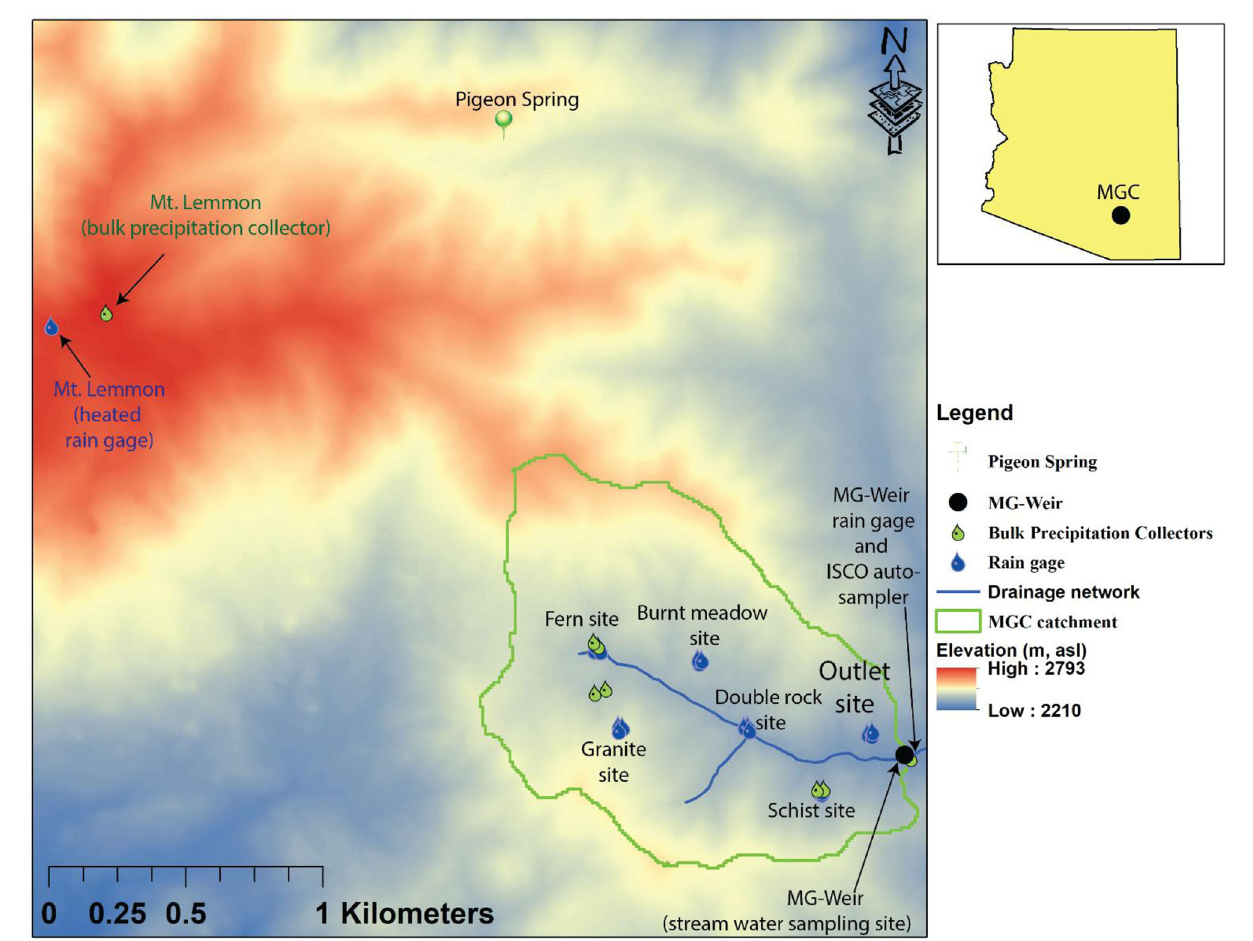
FIGURE 1 | Marshall Gulch Catchment (MGC; the catchment boundary is shown in green), located within the Santa Catalina Mountains Critical Zone Observatory (SCM-CZO) in southeast Arizona, USA (inset map), and the precipitation, stream water, and deep groundwater collection sites used in this study. The source of the digital elevation model is U.S. Geological Survey (2021a) and the source for the drainage network data is U.S. Geological Survey